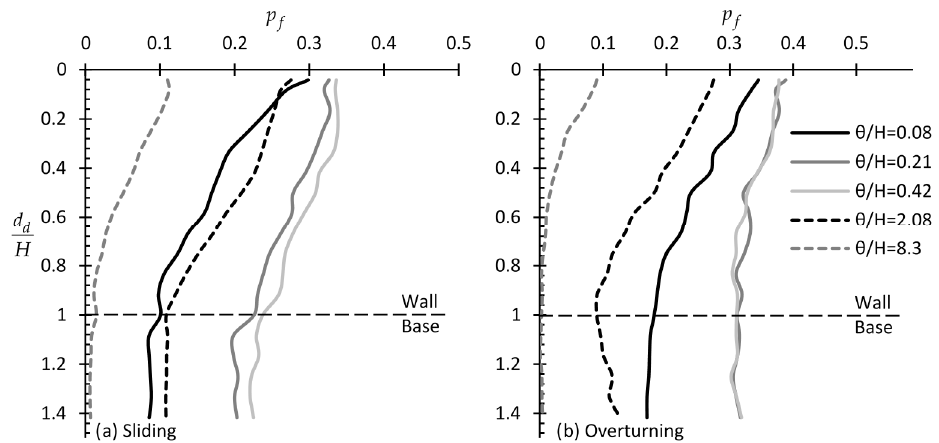
Figure 12. p f − d d / H curves for x / H = 0.5 and di ff erent θ / H values for the ( a ) sliding and ( b ) overturning Figure 12. f p - d d H curves for x H = 0.5 and different H θ values for the ( a ) sliding and ( b ) mode of failure. overturning mode of failure.